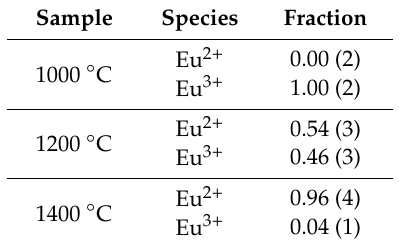
Table 4. Fitting results of Eu 2 + and Eu 3 + L 3 -edge WLs from CAO particles synthesized at 1000,